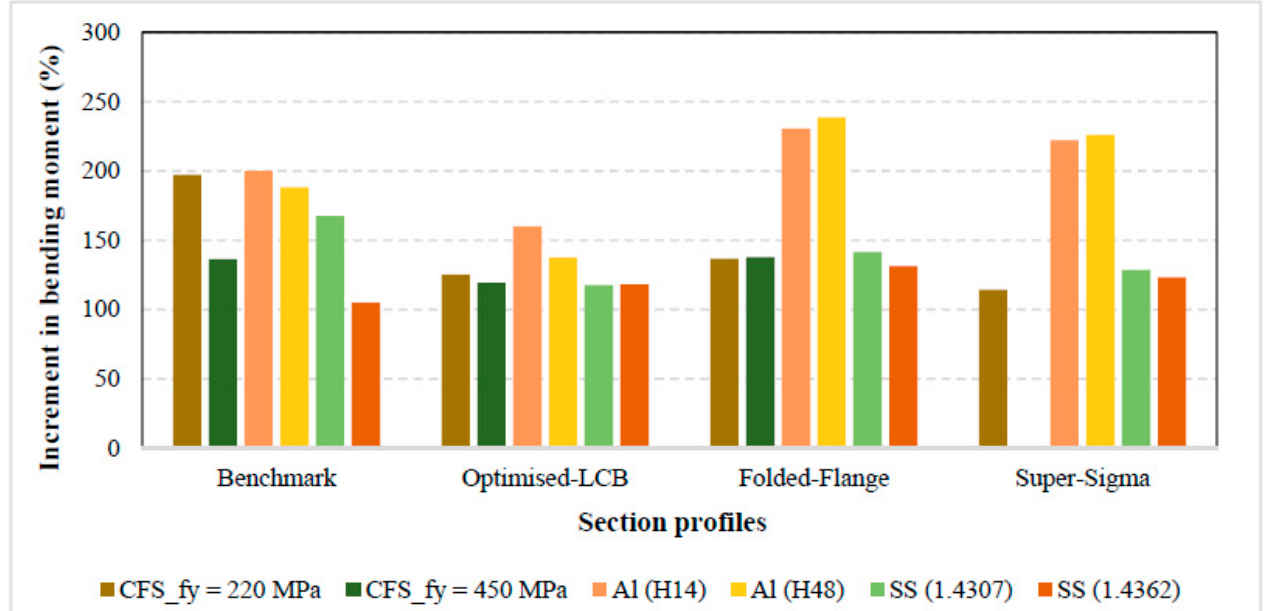
Figure 14. Bending capacity increment comparison between built-up and single sections based on different cross-sections.